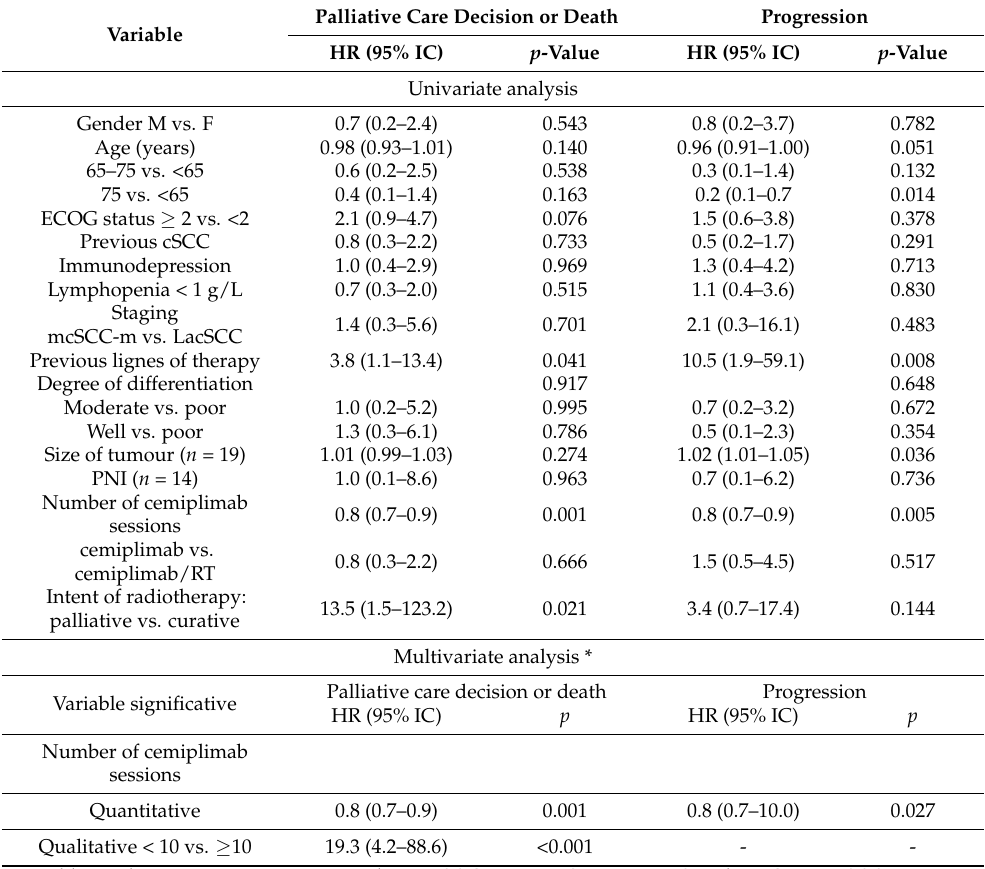
Table 3. Univariate and multivariate analyses (Cox model).